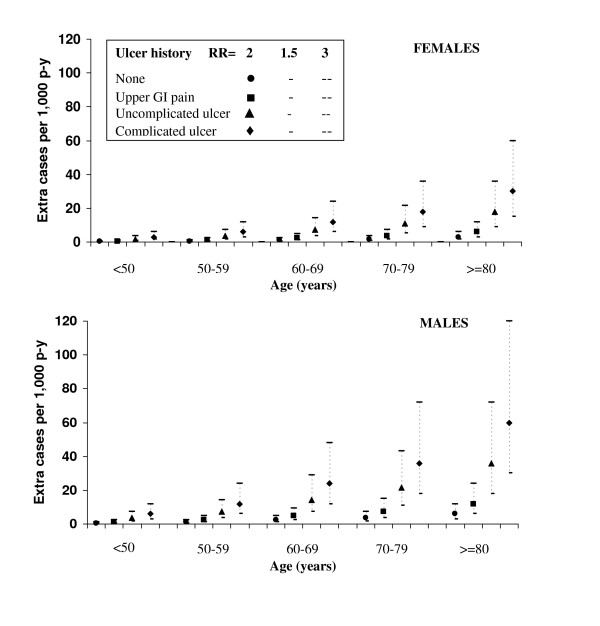
Sensitivity analysis. Estimated excess number of upper gastrointestinal tract complications (UGIC) cases attributable to aspirin (measured as the incidence rate difference between users and non-users) stratified by prior ulcer history and age for male and females, assuming a range of relative risks for aspirin from 1.5 to 3.